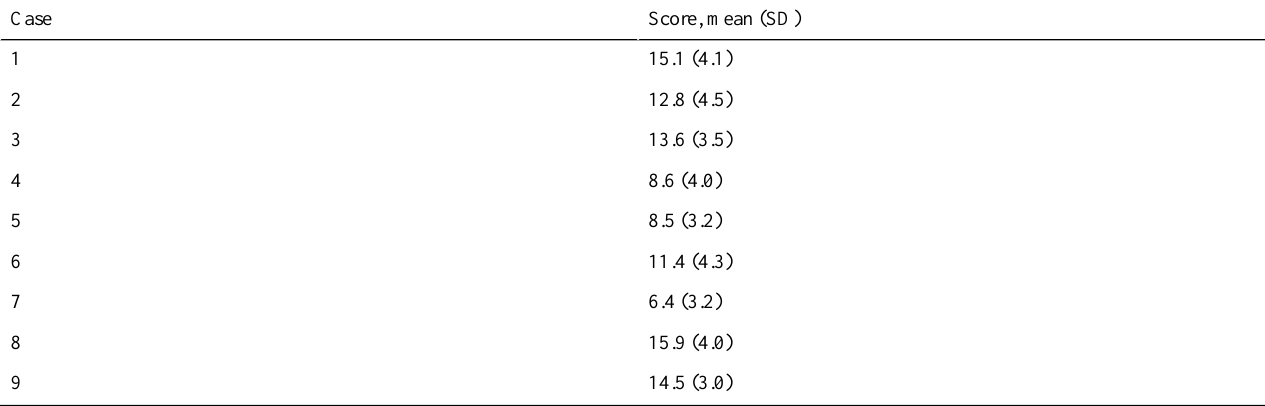
Table 2. Mean objective structured radiology examination scores for